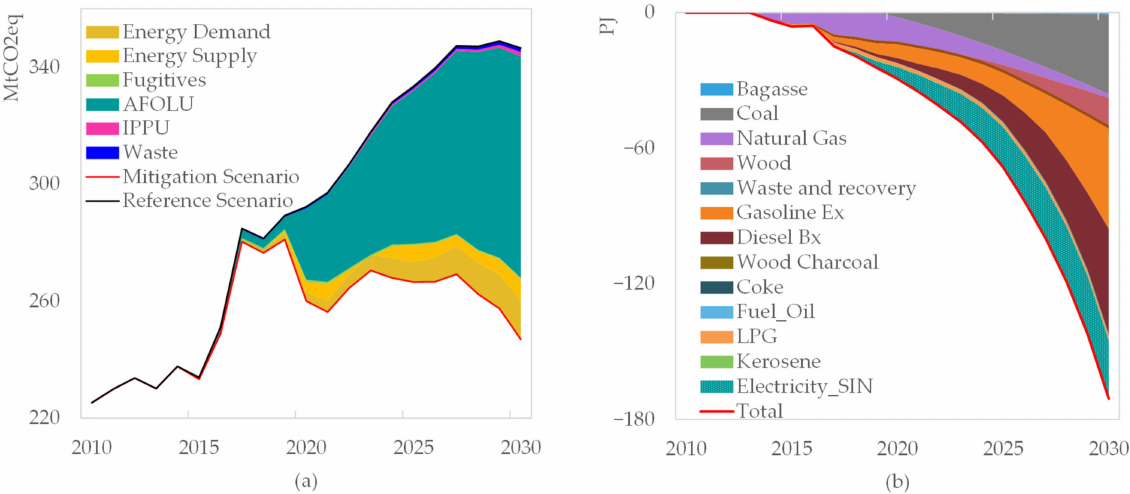
Figure 3. ( a ) GHG emission reductions by IPCC category and ( b ) energy demand changes by energy vector in the mitigation scenario compared with the reference scenario.